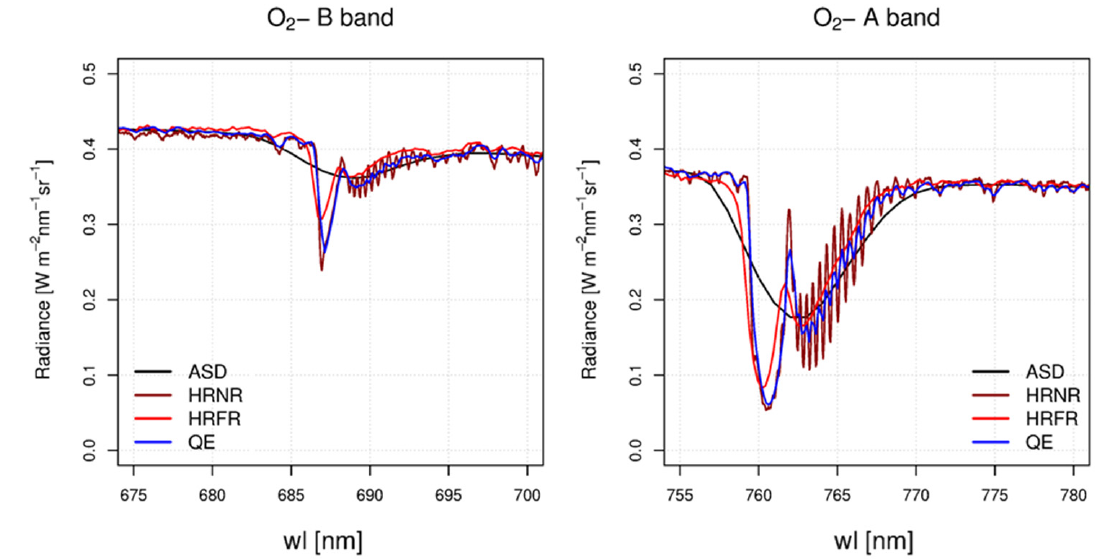
Figure 2. Incoming radiance measured with the four spectroradiometers in the O 2 -B band ( left ) and in the O 2 -A band ( right ). Each color represents a different instrument. The ability to detect the presence of narrow absorption features is directly related to the Spectral Resolution ( i.e. , FWHM) of each device.